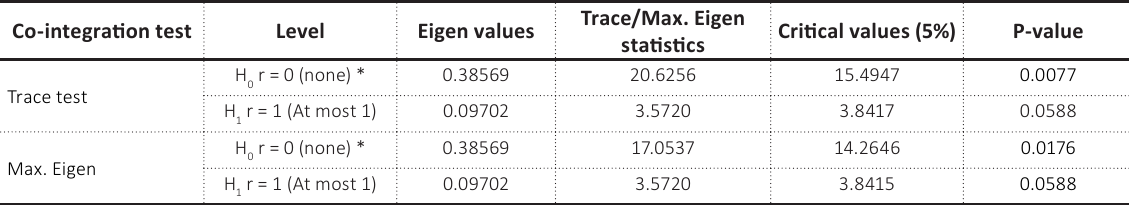
Source: EViews software